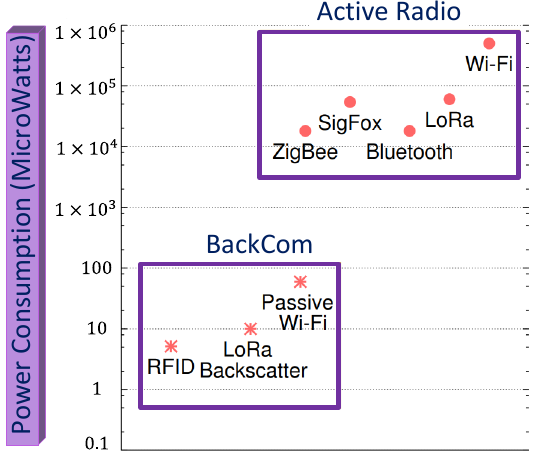
Figure 30. Power consumption of active and BackCom